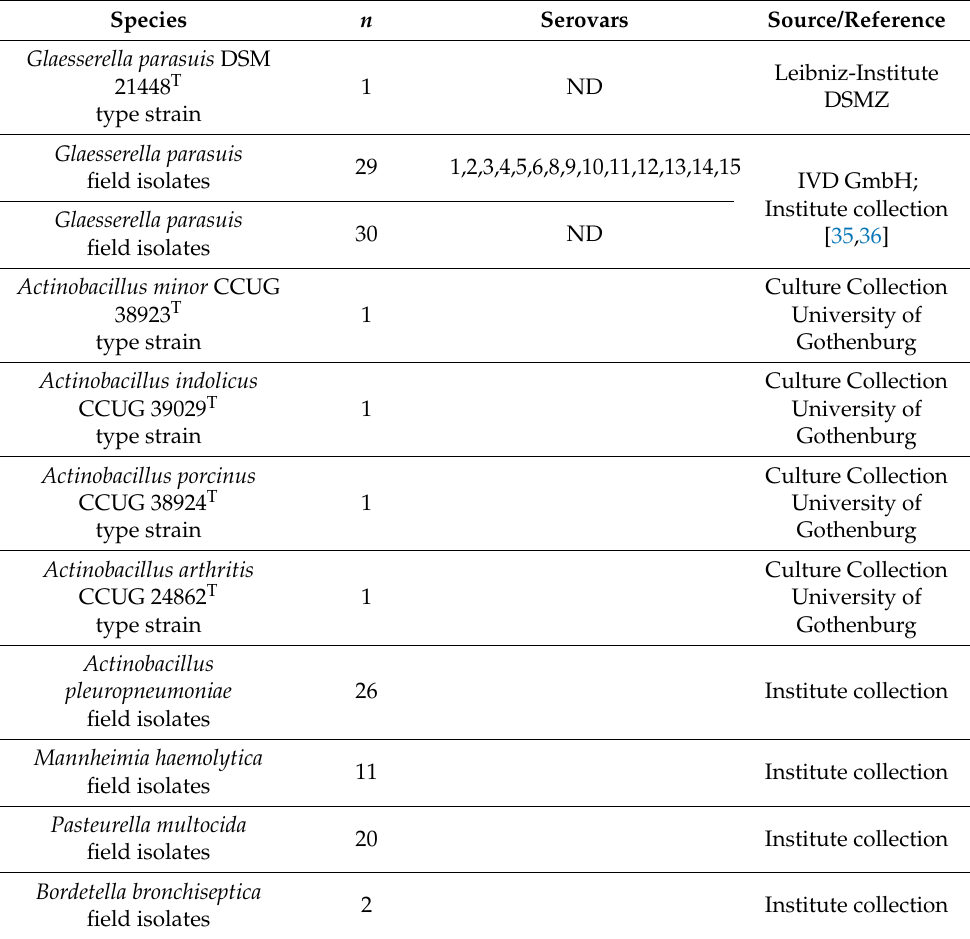
Table 1. Numbers, sources, and serovars of bacterial strains and isolates used for inclusivity and exclusivity tests in this study ( G. parasuis and non- G. parasuis